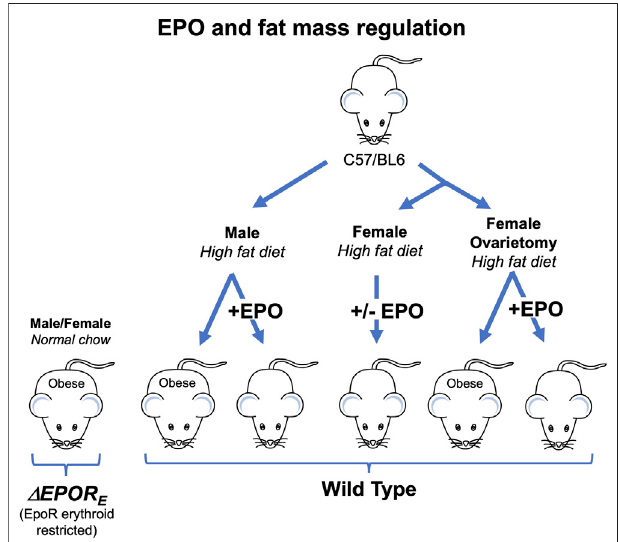
FIGURE 2 | Erythropoietin regulation of fat mass in mice is sex-speci fi c. Maleandfemale Δ EPOR E micewithEPORrestrictedtoerythroidtissueexhibit increased gain in body weight and fat mass on normal chow diet and become obese. Male, but not female, wild type (C57BL/6) mice fed high fat diet become obese while male mice on high fat diet and treated with EPO show increase hematocrit without change in fat mass. Ovariectomy eliminates the protective effect of estrogen against diet induced obesity in females and ovariectomized mice fed high fat diet become obese, but not ovariectomized mice treated with